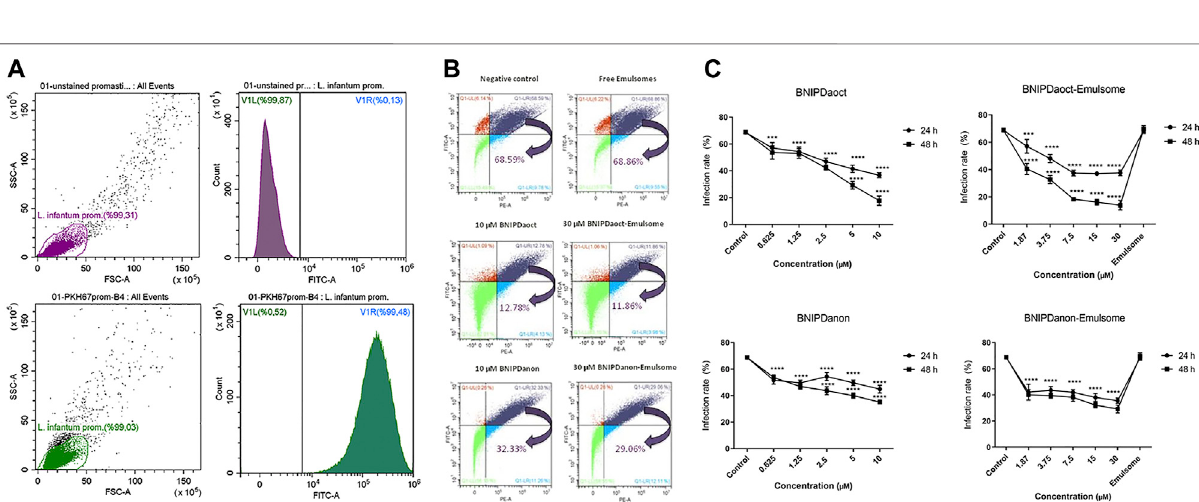
FIGURE 6 | (A) PKH67 staining. Percentage of unstained and staining achieved by PKH67-staining protocol on promastigotes as determined by fl ow cytometry. (B,C) Infection rates (%) of macrophages with L. infantum promastigotes upon treatment with free BNIP and BNIP-loaded emulsomes as determined by fl ow cytometry (B) dot-plot data representation (for 48 h) and (C) graphical demonstration (24 – 48 h) for negative control, free BNIPDaoct, free BNIPDanon, BNIPDaoct-loaded, and BNIPDanon-loaded emulsome treatment groups. Data represents mean ( n (cid:2) 3) ± SD. Statistical signi fi cance was determined using two-way ANOVA with Tukey ’